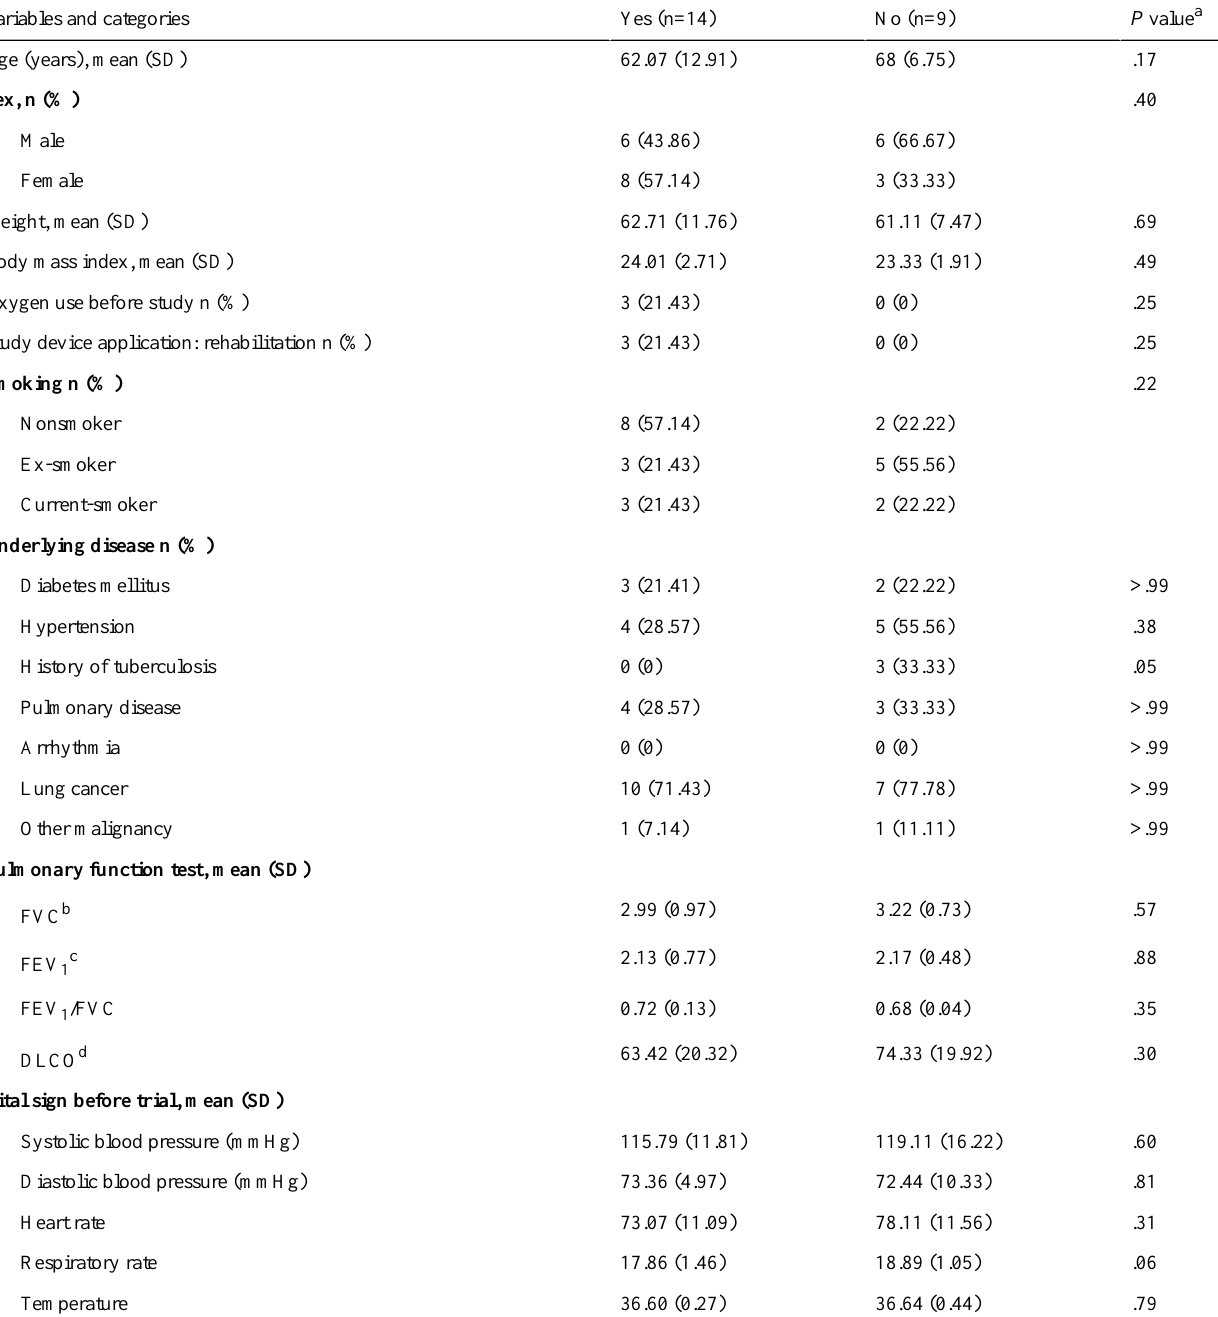
Table 2. Characteristics of the patients with abnormal signals (“yes”) versus those without (“no”) during transport (N=23).